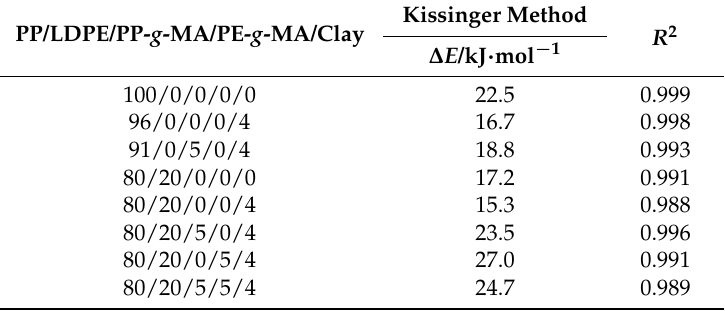
Table 4. Activation energies for the overall non-isothermal crystallisation of PP, the blend, and the binary and ternary